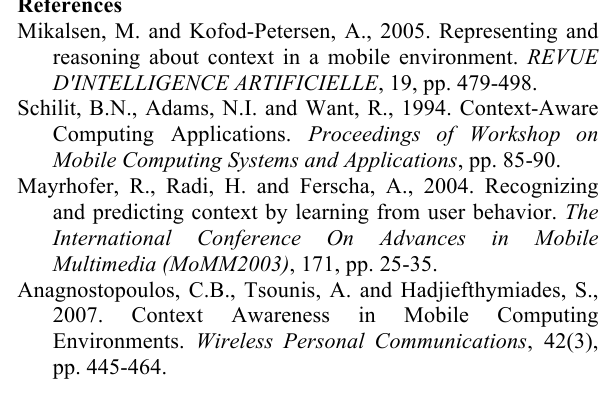
Figure 6. Areas that meet both